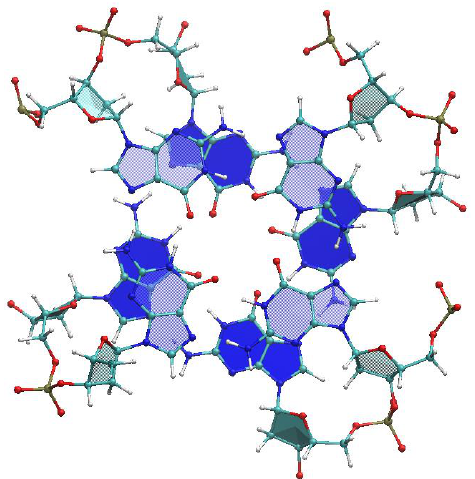
Figure 4. Exemplifying structure of a (G4) 2 dimer. This is taken from the G-quadruplex 1XAV, which contains three tetrads. The tetrads shown here included guanines 4, 8, 13, 17, 5, 9, 14, 18, as labeled in the PDB file.